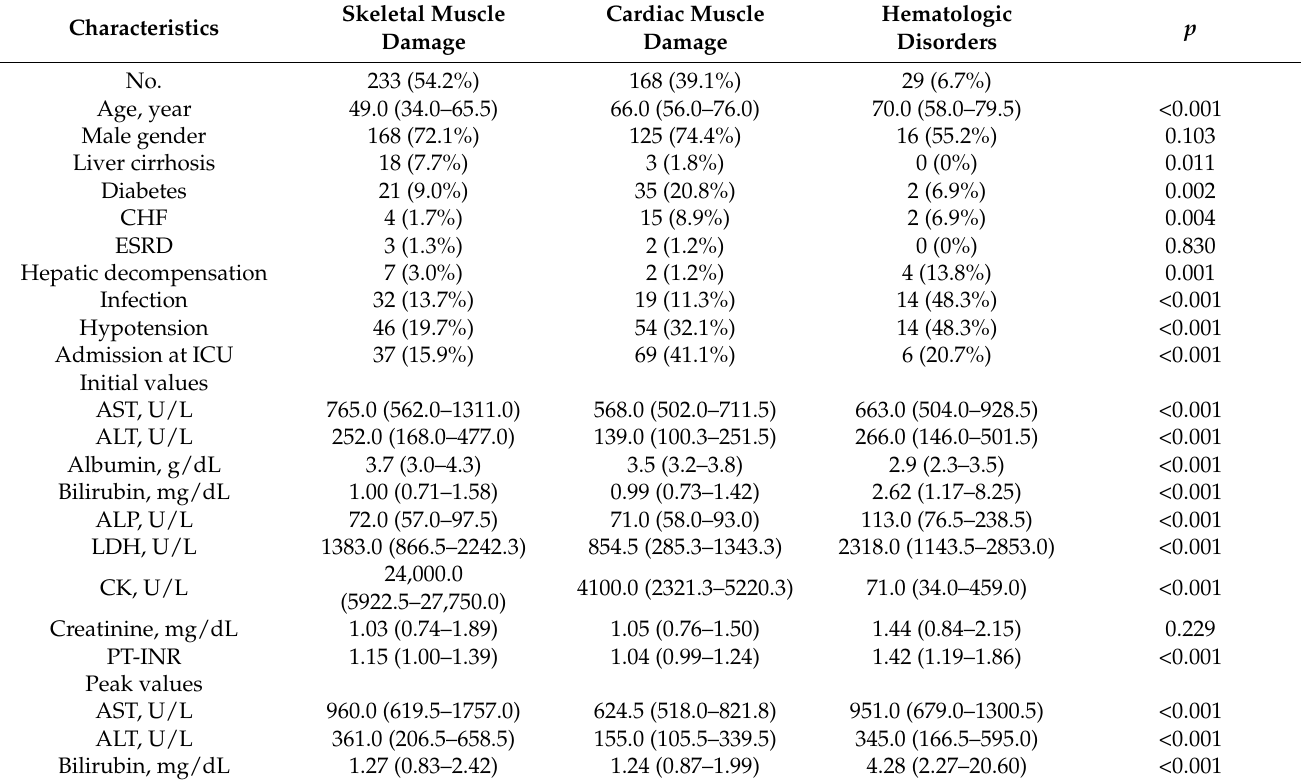
Table 2. Clinical and laboratory characteristics of patients according to etiology ( n =